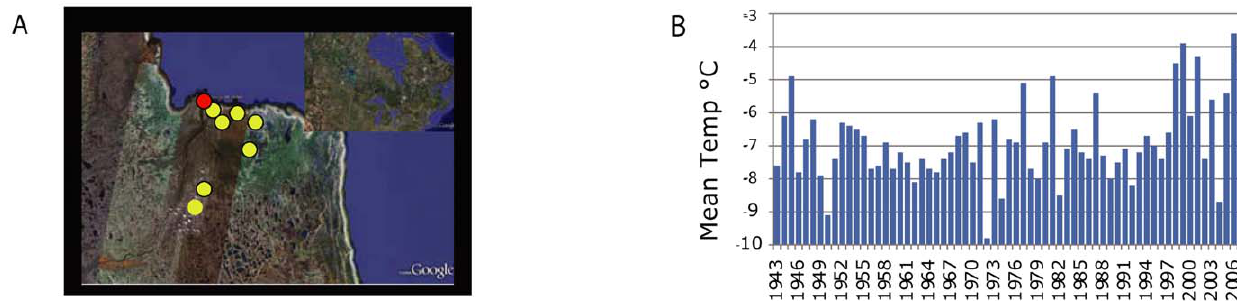
Figure 3. Churchill collection localities and temperature data. A ) Map of Churchill (red circle) Manitoba and its surroundings. Yellow circles mark contemporary and historical collecting sites; orange circles mark contemporary only collecting sites. B ) Average mean temperature at Churchill airport (data: Environment Canada, National Climate Data and Information Archive [58]). The decade between 1997 and 2007 saw 6/10 of the hottest years, and all of the top five.